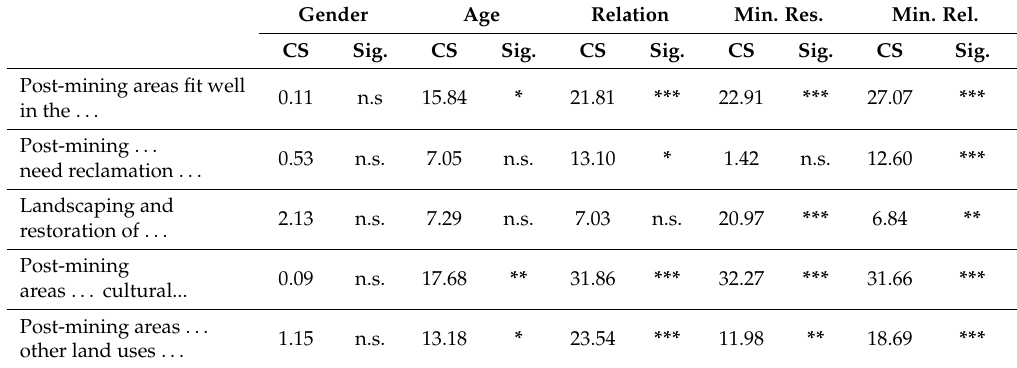
Table 2. Chi-square statistics for respondents’ opinions on statements related to post-mining landscapes in the Hannukainen/Rautuvaara region. See Figure 4 for full statements. Relationships between opinions (agree/disagree) and gender, age, relationship to the region, respondent’s work in the mining industry, and respondent’s relative(s) work in the mining industry were examined. Gender Age Relation Min. Res. Min. Rel. CS Sig. CS Sig. CS Sig. CS Sig. CS Sig. Post-mining areas fit well in the . . .